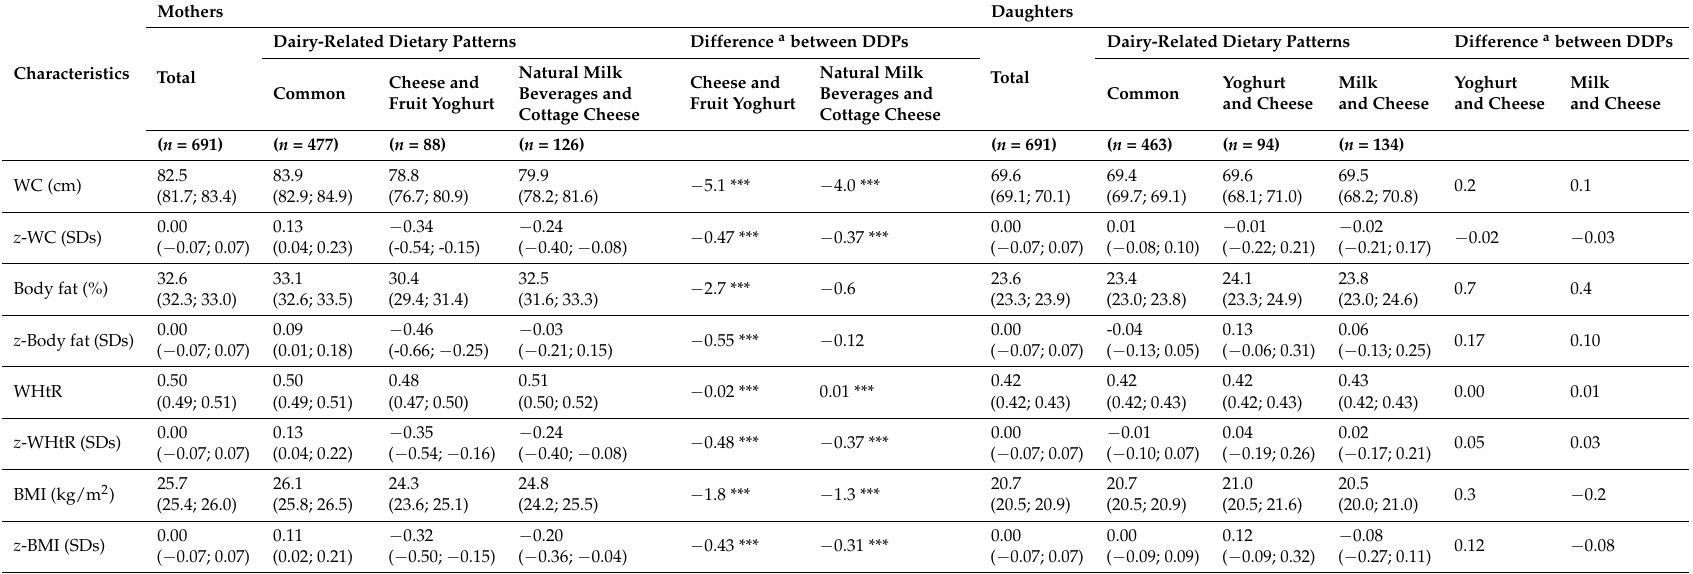
Table 3. Means (with 95% confidence interval) of body weight and composition characteristics by dairy-related dietary patterns.